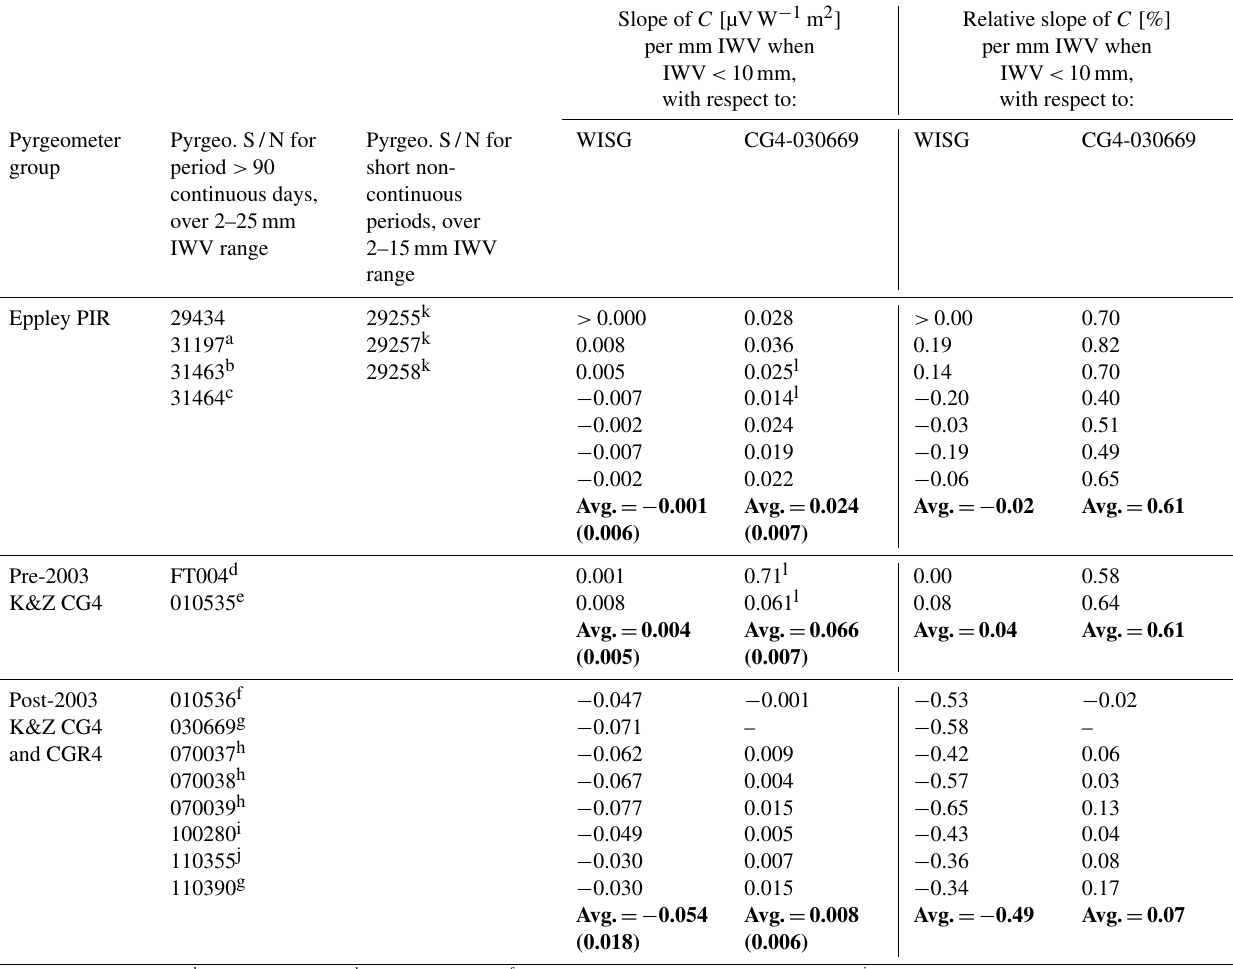
Table 2. Summary of pyrgeometers previously calibrated at PMOD/WRC with sufficient measurements to allow the dependence of C on IWV to be characterised. Slope values of C per millimetre IWV when IWV < 10mm are shown with respect to the WISG and PMOD/WRC pyrgeometer CG4-030669. These results are also shown as relative values in percent. Numbers in brackets represent the standard deviation, while average values in bold are discussed in the